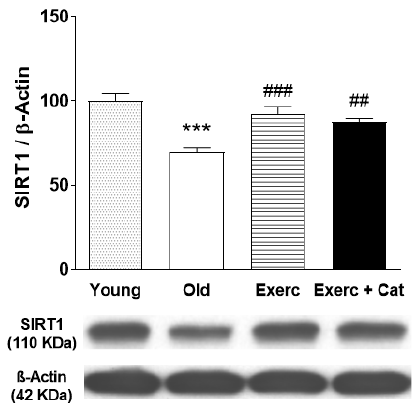
Figure 5. Effect of exercise and the combined action of exercise and catechin treatment on SIRT1 (110 kDa) protein expression in the hippocampus of old rats and young control rats. Bars represent mean ± SEM of protein levels per group (animals subjected to exercise, Exerc, n = 7; exercise together with catechin, Exerc + Cat, n = 7; old control group, Old, n = 6) expressed as a percentage with respect to the young control group ( n = 6). Protein level was normalized to β -actin content and each sample was analyzed in three different membranes. One-way ANOVA detected a significant effect (F(3,22) = 17.48, p < 0.0001). *** p < 0.001 when compared with young animals in the control group; ## p < 0.01, ### p < 0.001 when compared with old animals in the control group (one-way ANOVA, followed by Bonferroni test). A representative immunoblot of the changes obtained in SIRT1, with no changes in ß-actin (loading pattern), is shown below the